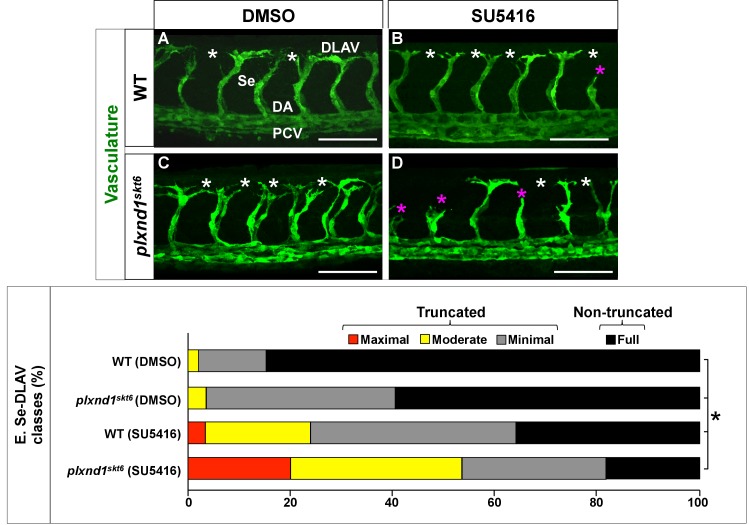
plxnd1skt6 mutants are hypersensitive to the antiangiogenic drug SU5416.(A–D) Confocal lateral images of the trunk vasculature (green) of 32 hpf embryos (region dorsal to the yolk extension). Anterior, left; dorsal, up. Scale bars (white horizontal lines), 100 μm. Treatments (DMSO or SU5416) indicated on top, genotypes (WT or plxnd1skt6) indicated on the left. Angiogenesis deficits are indicated with asterisks as follows: white (DLAV gaps), magenta (truncated Se). In the image of the DMSO-treated WT (C), the vessels are designated with the white font as follows: DLAV (Dorsal Longitudinal Anastomotic Vessel), Se (Segmental Vessel), DA (Dorsal Aorta), and PCV (Posterior Cardinal Vein). (E) Bar graph. Percentage of Se-DLAV in 32 hpf embryos of the indicated genotype and treatment combinations belonging to each of the following four phenotypic classes. Truncated: maximal (red; includes missing Se), moderate (yellow), and minimal (gray). Non-truncated: Full (black). The distributions of these four phenotypic classes were statistically significantly different between all the possible pairwise comparisons of the four combinations of treatments and genotypes. Significance values were calculated using a two-sided Fisher Exact test and significant differences (p<0.0083) assigned using a Bonferroni-type adjustment for six pairwise genotype comparisons (0.05/6 = 0.0083). Quantifications. We scored Se-DLAV angiogenesis (A–E) in embryos of the following four combinations of treatments and genotypes: DMSO-treated WT (312 Se-DLAV, 28 embryos, an average of 11.14 Se-DLAV/embryo), DMSO-treated plxnd1skt6 (284 Se-DLAV, 26 embryos, an average of 10.92 Se-DLAV/embryo), SU5416-treated WT (322 Se-DLAV, 29 embryos, an average of 11.10 Se-DLAV/embryo), and SU5416-treated plxnd1skt6 (320 Se-DLAV, 28 embryos, an average of 11.43 Se-DLAV/embryo). For additional data, graphs and statistical comparisons related to this figure, see Figure 3—figure supplement 1 and Supplementary file 4.